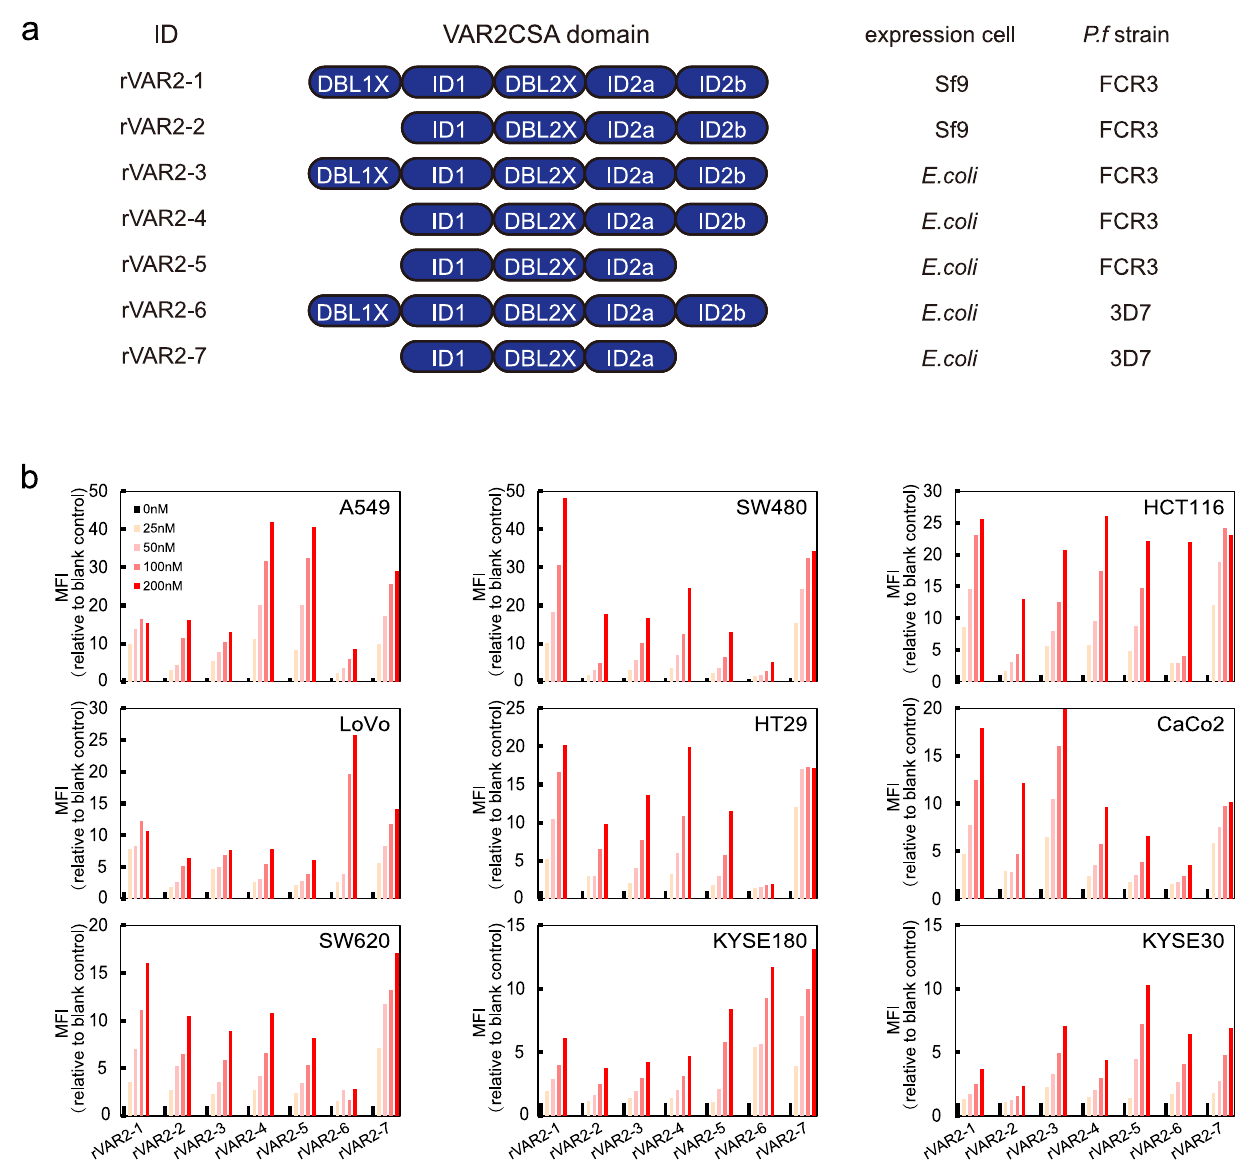
Fig. 1 | CSA binding ability of rVAR2. a Schematic illustration of rVAR2 with differentbindingdomainsandtheexpressioncellofsevenrVAR2toCSA. * rVAR2-3 was used as the detection molecular at the modi fi ed ELISA test. b Relative mean fl uorescence intensity (MFI) of lung adenocarcinoma cell line (A549), colorectal